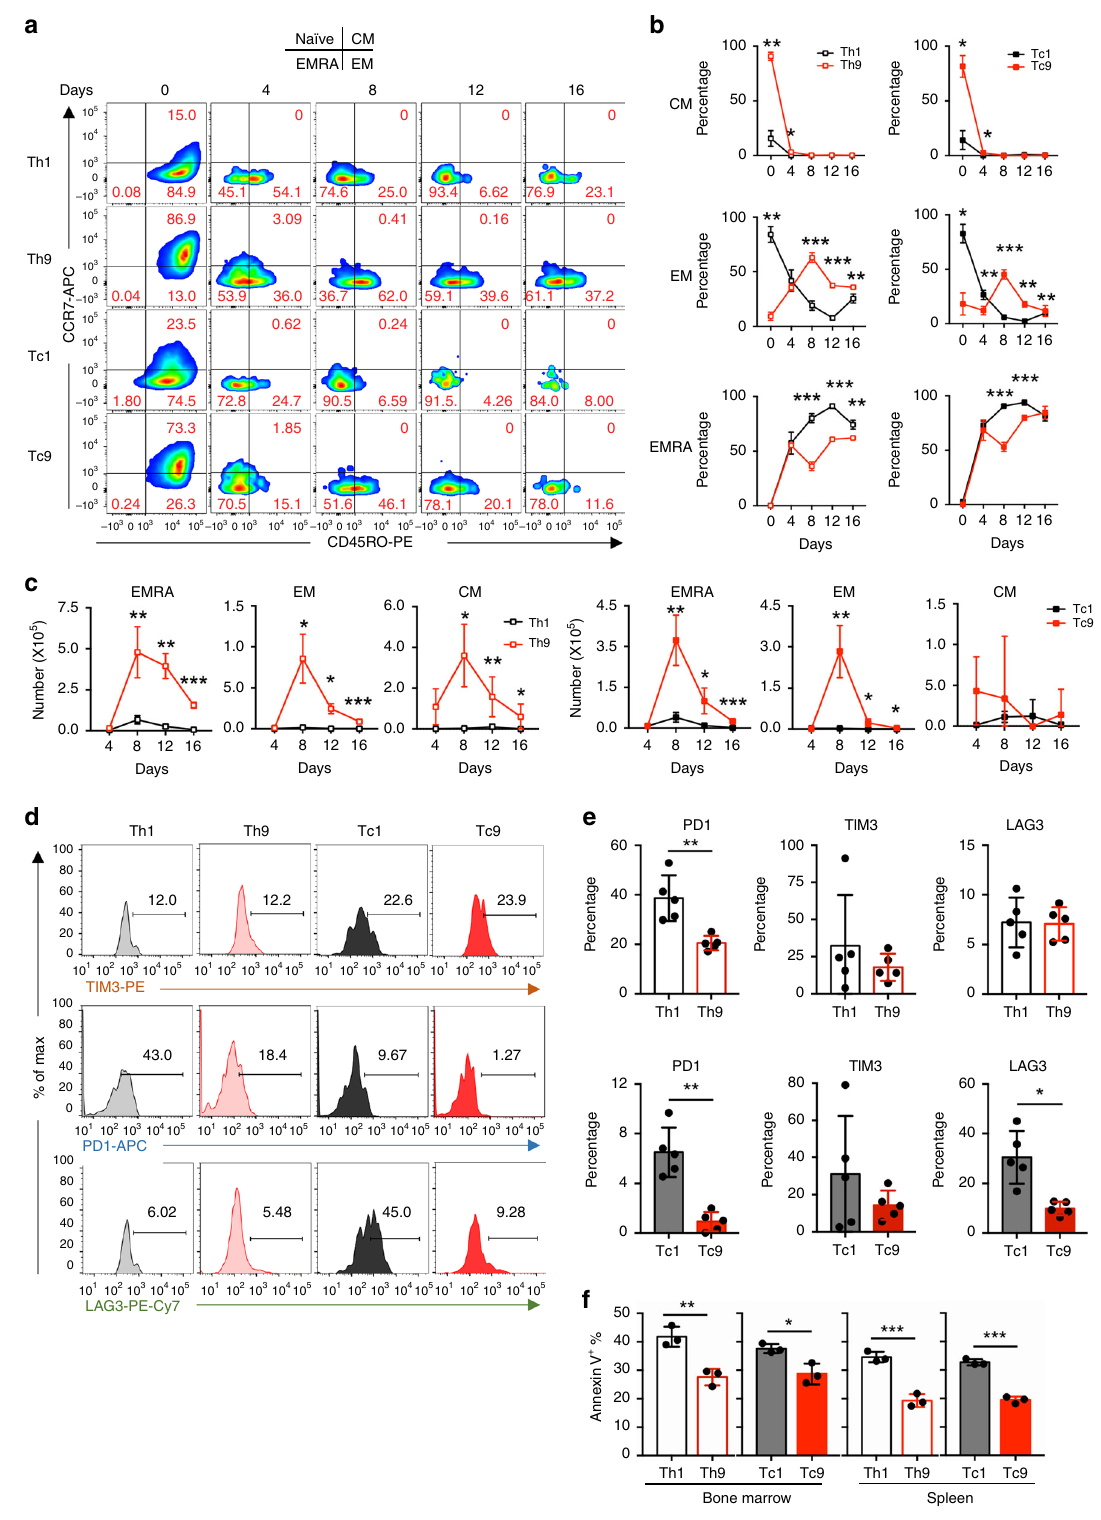
Fig. 6 T9 CAR-T cells are long-lived and less-exhausted T cells in vivo. a Representative fl ow plots showing the frequency of CD4 + or CD8 + CCD7 + and CD45R0 + CAR-T cells from spleen of treated mice at indicated days after CAR-T cell infusion. Cells were pre-gated for GFP + CD3 + CD8 + or GFP + CD3 + CD4 + T cells. b Frequency and c total numbers of T cell subsets in CAR-T cells in spleen of treated mice at indicated days after CAR-T cell infusion ( n = 4 mice at day 4, n = 5 mice at other days). d Representative fl ow plots showing expression of different exhaustion markers on CAR-T cells from spleen of treated mice at day 4 after CAR-T cell infusion. e Frequency of PD1 + , TIM3 + , and LAG3 + Th1 or Th9 (upper panels) and Tc1 or Tc9 (lower panels) CAR-T cells in spleen of treated mice at day 4 after CAR-T cell infusion ( n = 5 mice). f Frequency of annexin V + apoptotic CAR-T cells in bone marrow and spleen of treated mice at day 4 after transfer ( n = 3 mice). Data are presented as mean ± SD. * P < 0.05 and *** P < 0.001, two-sided Student ’ s t -test. Source data are provided as a Source Data fi